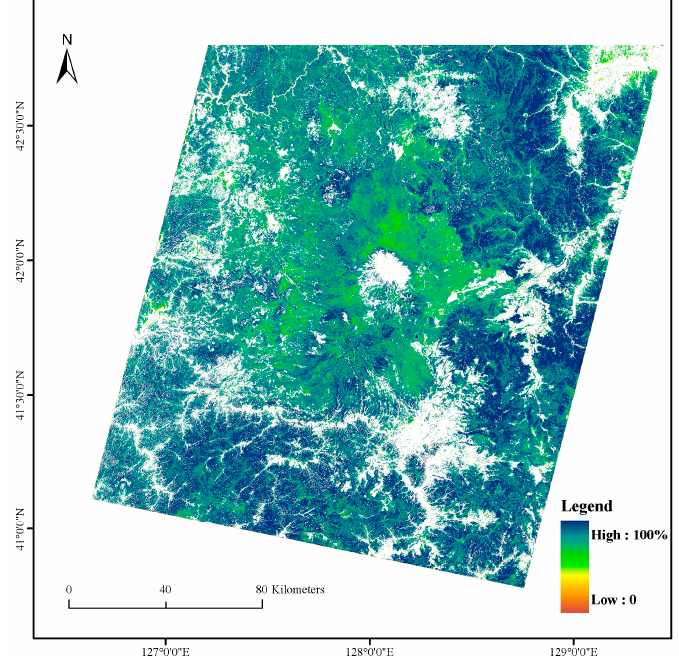
Figure 3. Canopy closure map. Table 6. Canopy closure estimation of four forest